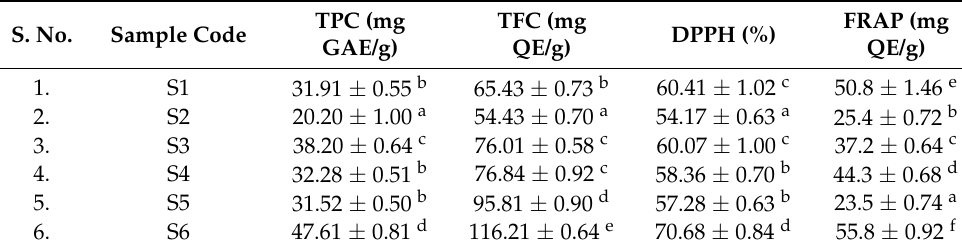
Table 6. Total phenolic content (TPC), total flavonoid contents (TFC), FRAP, and DPPH values measured in different varieties of turmeric